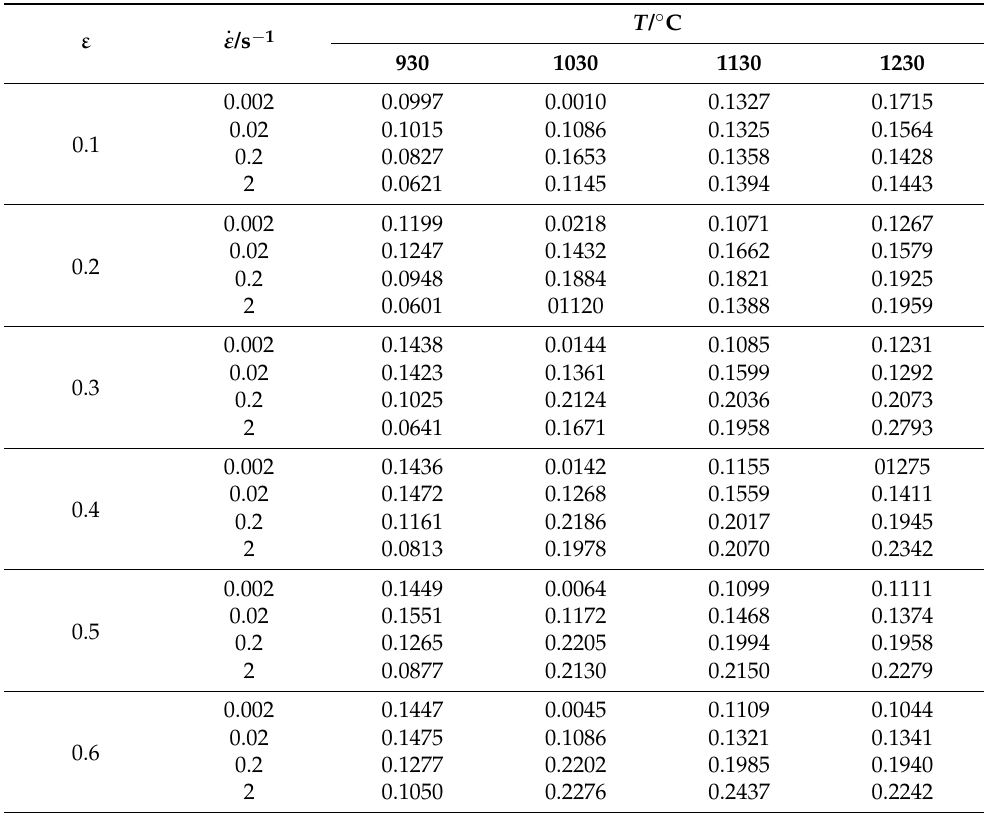
Table 5. The value of m of each computing node at different deformation